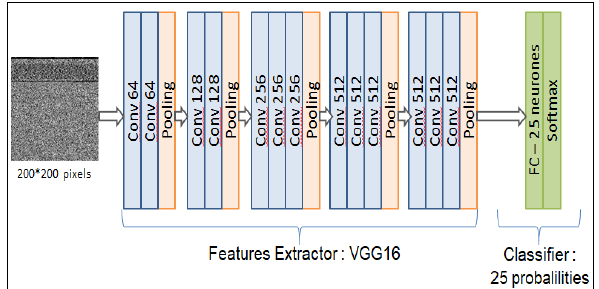
Figure 8. Our proposed CNN model for classification of malware represented as grayscale images using VGG16 as features extractor connected with optimised classifier for 25 families of